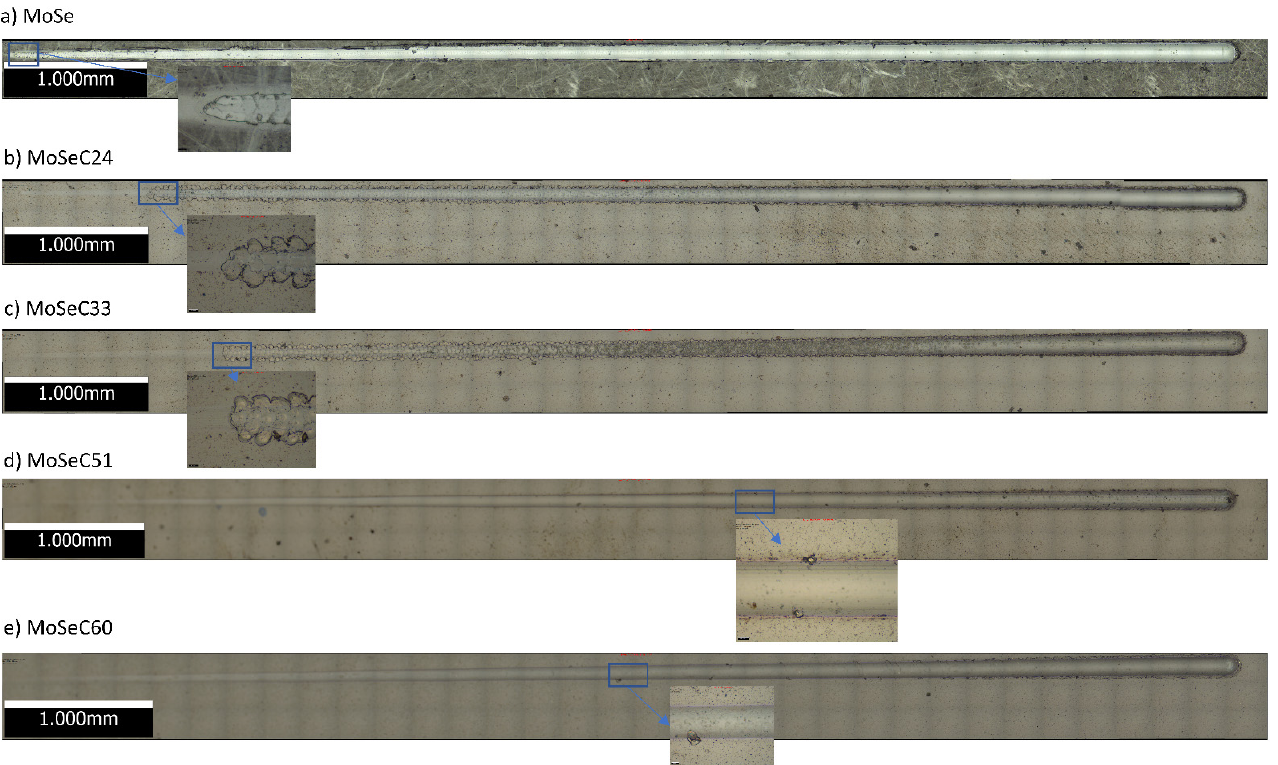
Figure 6. Scratch track micrographs: ( a ) MoSe coating; ( b ) MoSeC24; ( c ) MoSeC33; ( d ) MoSeC51; ( e ) MoSeC60.